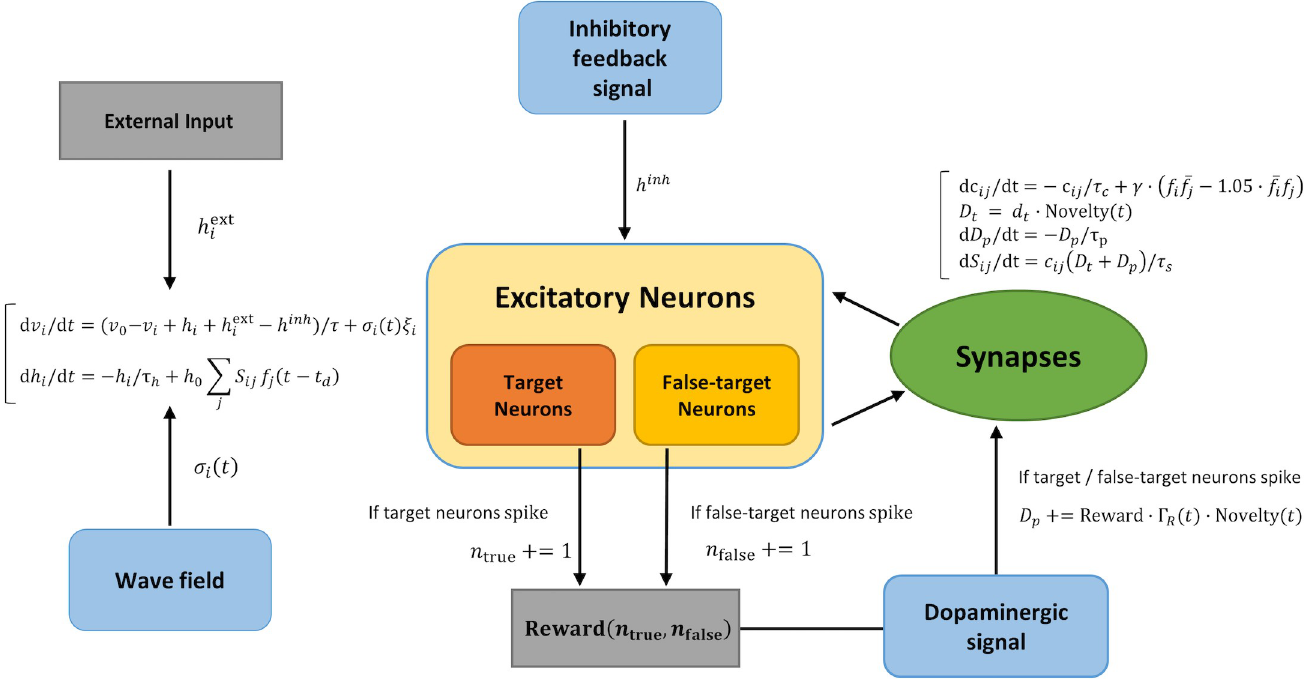
Fig 5. The whole system of our model. Excitatory neurons are locally connected via synapses. Inhibitory feedback signal controls the firing rate of excitatory neurons, global dopaminergic signal modulates the synaptic weights, and wavefield created by the activities of other neurons controls the activity level of each excitatory neuron. External input and reward functions are externally provided. The + = operator means that the right-hand-side is added to the left-hand-side when an event happens (with delay for D p ). We use the same parameters (except three parameters summarized in Table 1) to learn three qualitatively different tasks in different network architectures, which underscores the robustness of the learning rule and the role of traveling waves.